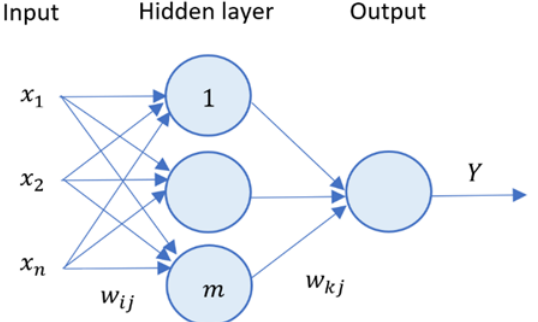
Figure 1. Architecture of a typical multilayered feed forward NN, where x i is the neuron input, w ij and w kj are the weights, m represents the number of neurons in the hidden layer, and Y is the output value.